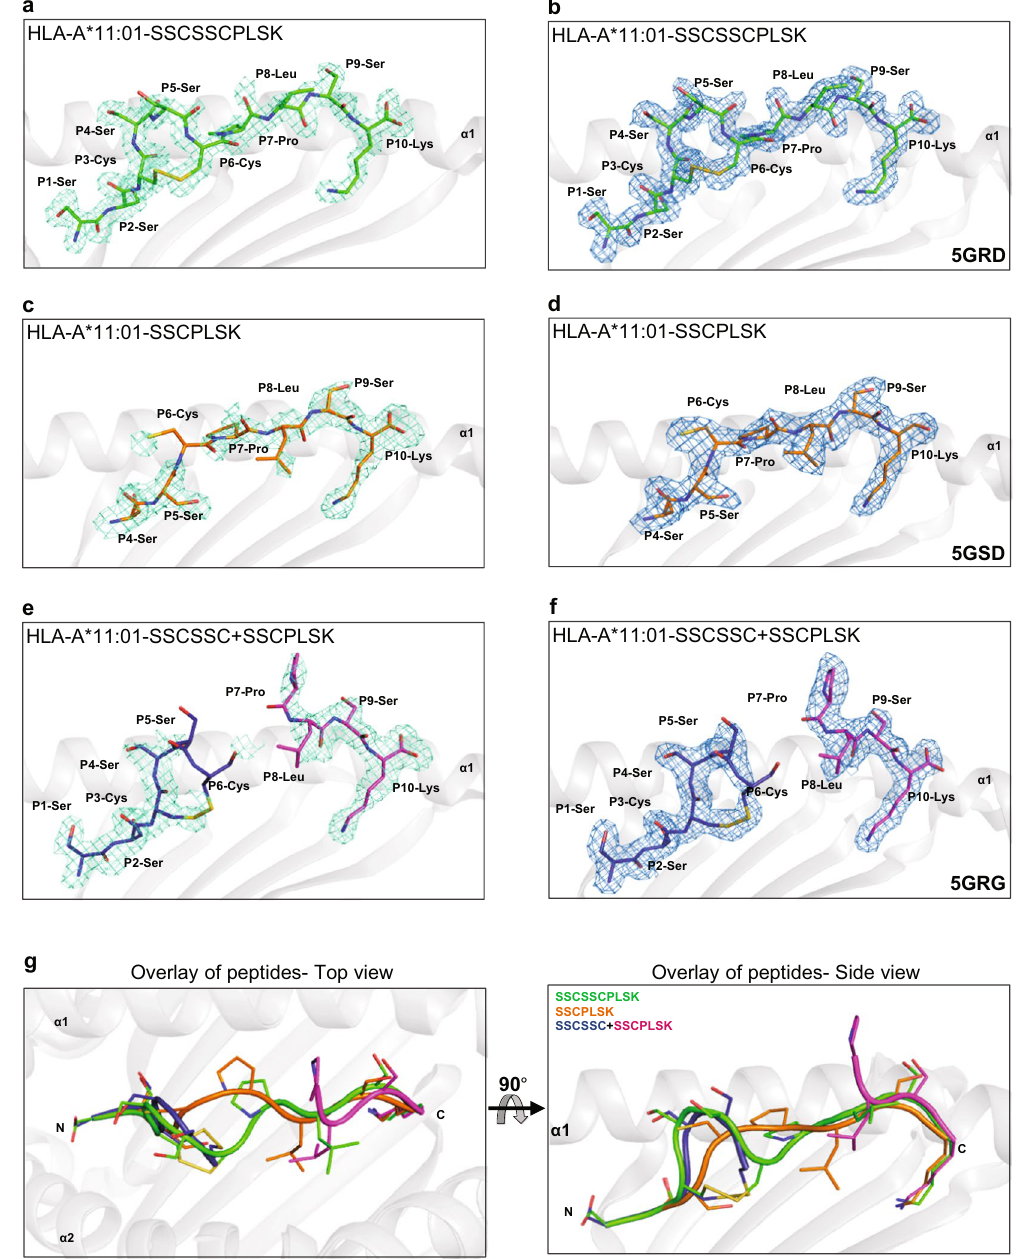
Figure 6. Electron density maps and comparison of SSCSSCPLSK, SSCPLSK and SSCSSC + SSCPLSK peptides bound to HLA-A * 11:01. Omit maps (F o -F c ) at 2.5 σ in green mesh and 2F o -F c maps at 1 σ in blue mesh after final refinement for each epitope in complex with HLA-A * 11:01 (grey) are shown respectively in ( a ) and ( b ) for SSCSSCPLSK (green; PDB code: 5GRD); ( c ) and ( d ) for SSCPLSK (orange; PDB code: 5GSD); as well as ( e ) and ( f ) for SSCSSC + SSCPLSK (dark blue and magenta; PDB code: 5GRG). The peptide residues are represented in sticks. ( g ) The three peptides in the cleft of HLA * 11:01 molecules were overlaid and compared. The left panel shows the top view of three peptides, SSCSSCPLSK (green), SSCPLSK (orange) and SSCSSC + SSCPLSK (dark blue and magenta) bound to HLA-A * 11:01 molecule obtained by aligning only the C α atoms. The right panel shows the side view of the overlap of the three peptides and the α 2 domain of HLA-A * 11:01 molecule is removed for clarity purpose. N- and C-termini of the peptides are